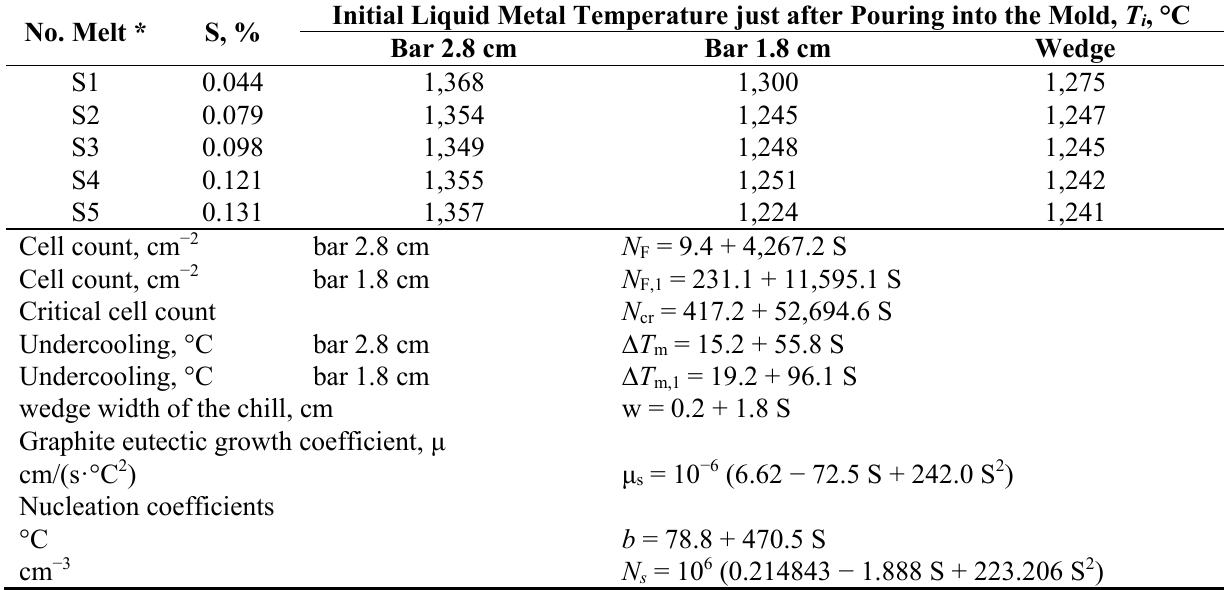
Table 8. Effect of S on the cast iron T i .